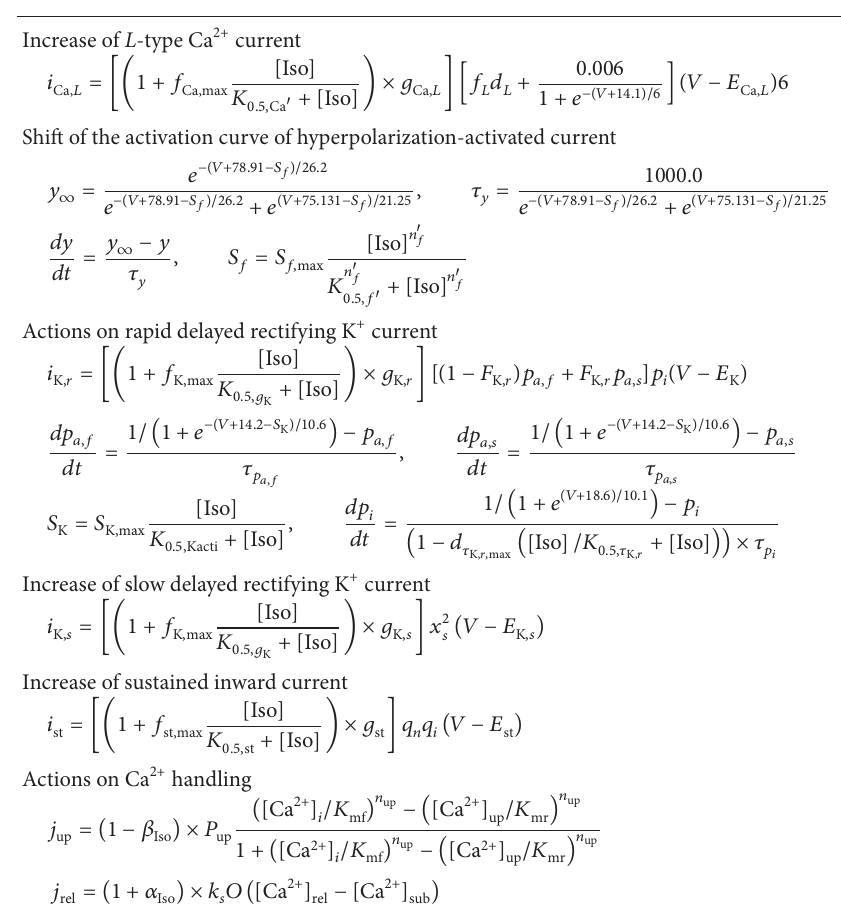
Table 2: Actions of Iso on